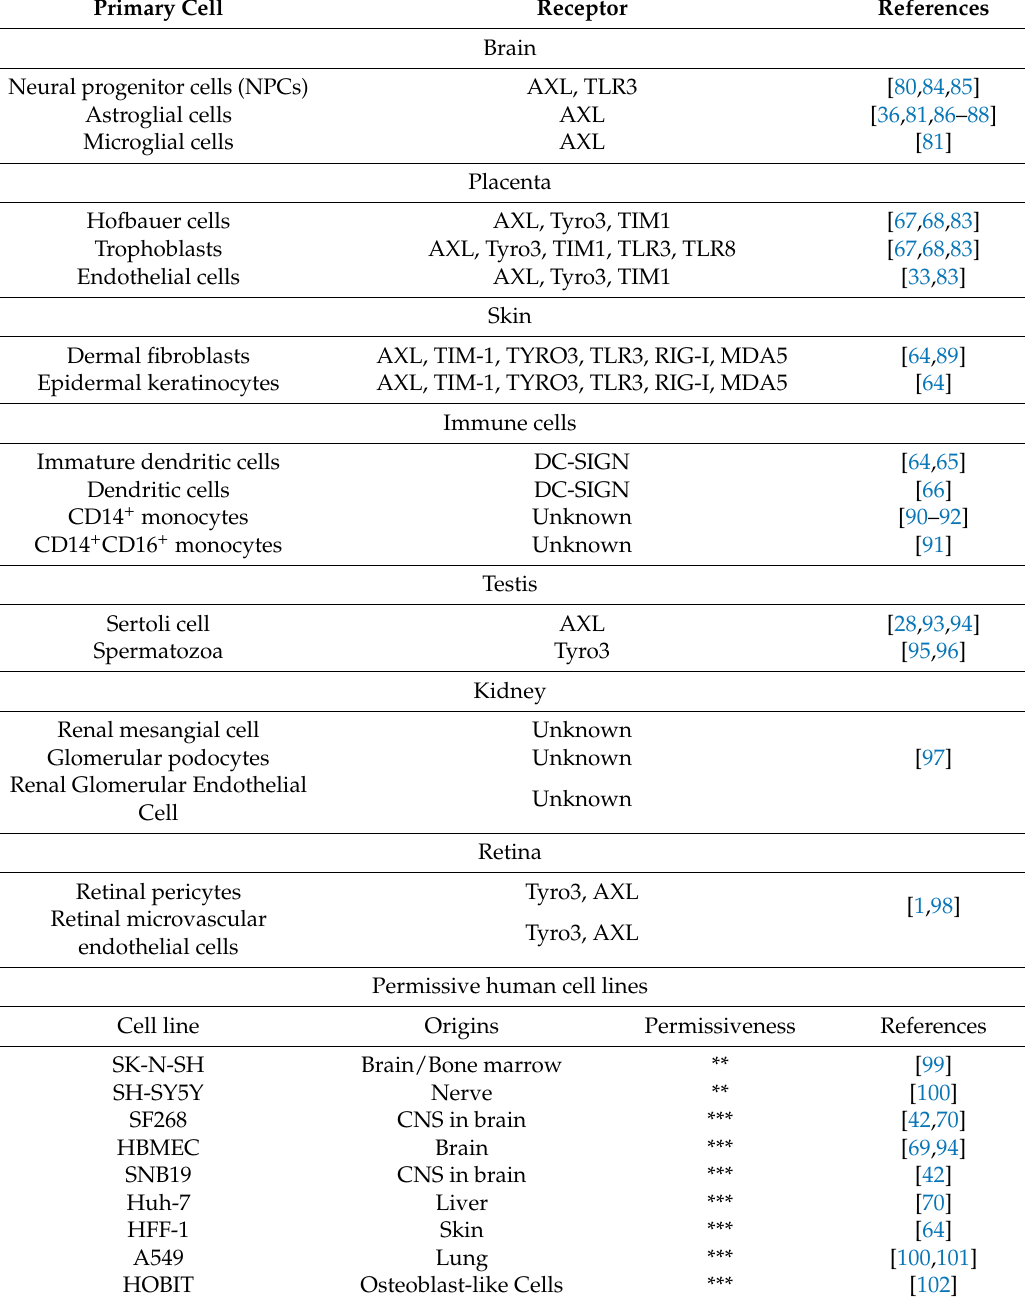
Table 2. Cellular targets and receptor